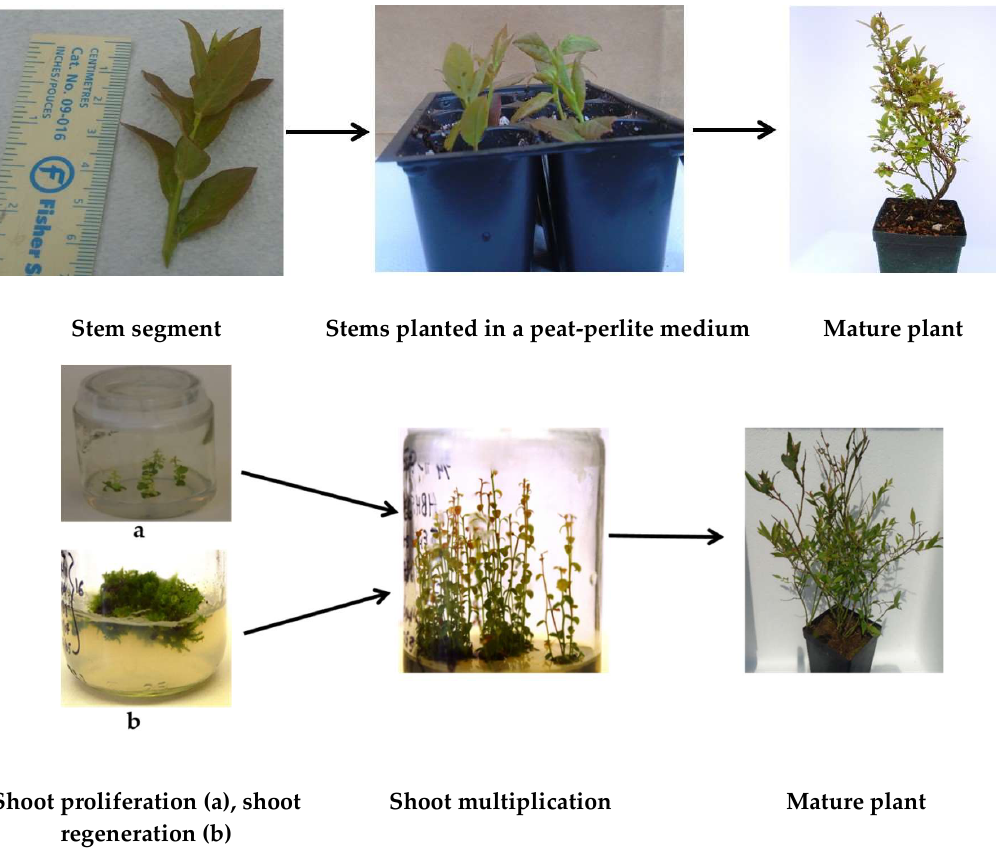
Figure 1. Softwood cutting propagation (upper panel) and micropropagation (lower panel) of lowbush blueberry [30,130].